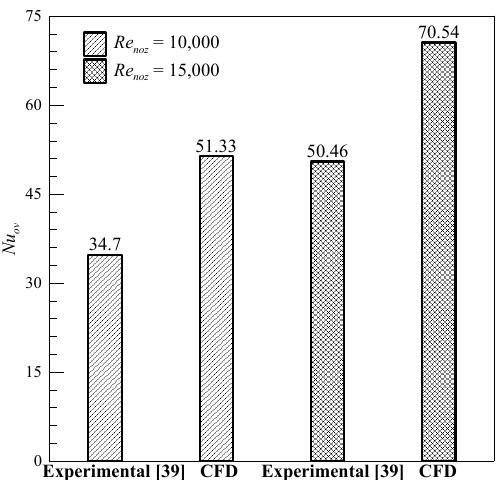
Figure 20. Experimental swirl cooling versus compound cooling at identical values of Re noz .